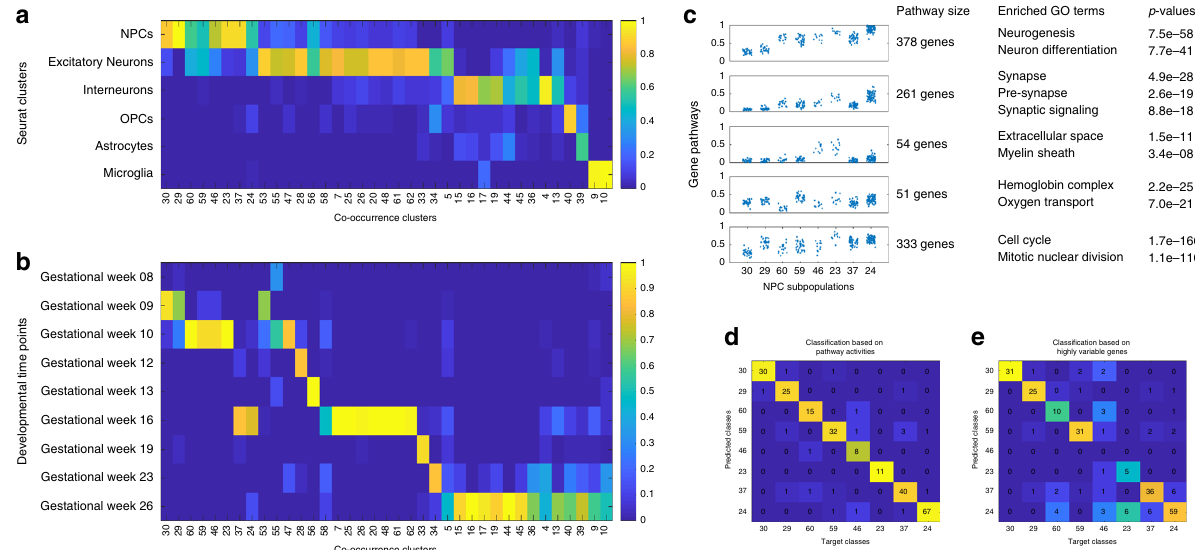
Fig. 3 Co-occurrence clustering applied to dropout pattern in human prefrontal cortex data. a Comparison between co-occurrence clusters and seurat clusters. Each column was colored by the percentages of cells in one co-occurrence cluster that belonged to each of the experimentally de fi ned cell type. b Comparison between co-occurrence clusters and clusters de fi ned by developmental time points when the cells were collected. c Pathway activities and enriched GO terms. Enrichment is evaluated by one-sided hypergeometric test on the overlap between identi fi ed pathways and GO gene sets provided by MSigDB. The reported p -values are unadjusted. d , e Random Forest classi fi cation and 5-fold cross-validation of the co-occurrence clusters based on pathway activities and highly variable